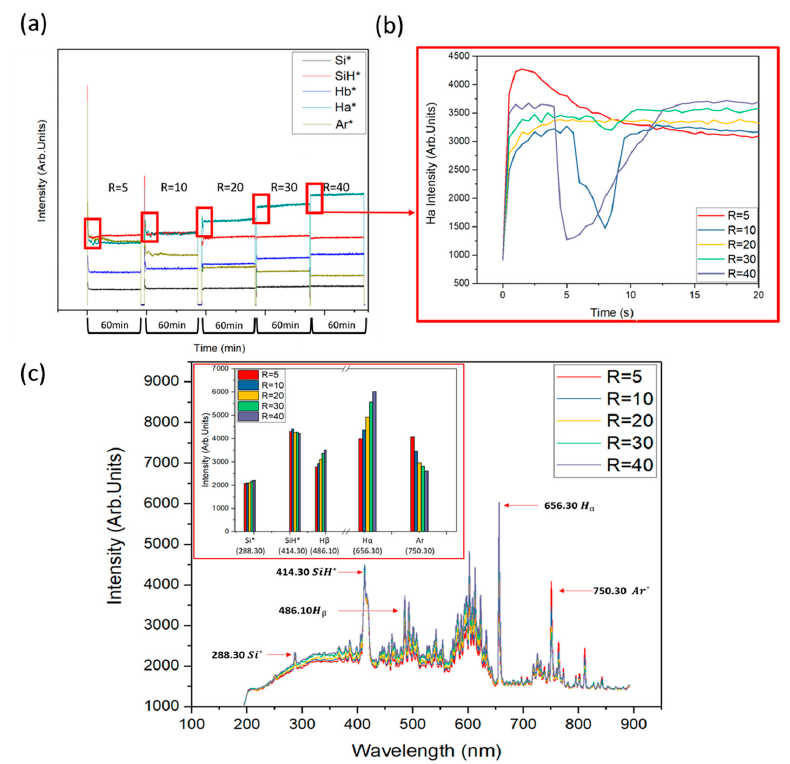
Figure 1. ( a ) Time sequence of Si*, SiH*, and H α * by optical emission spectra (OES)-resolved measurement; ( b ) Transient behavior of the initial 20 s of OES intensity for H α intensity; and ( c ) Characteristics of OES.